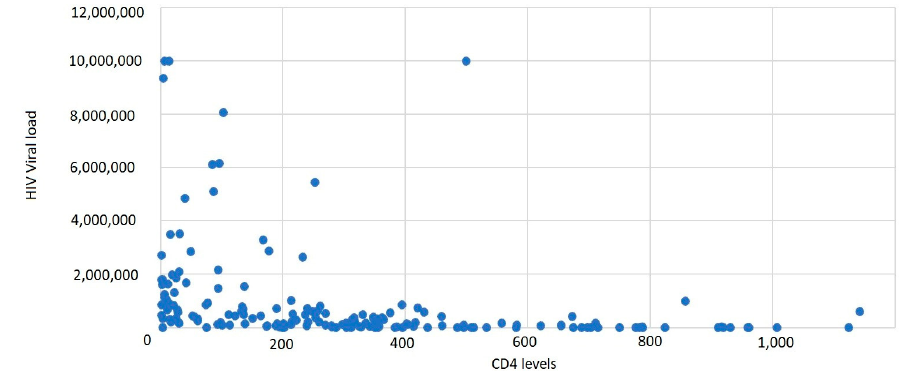
Figure 3. Distribution of cases by CD4+ T-lymphocyte level (cells/ μ L).